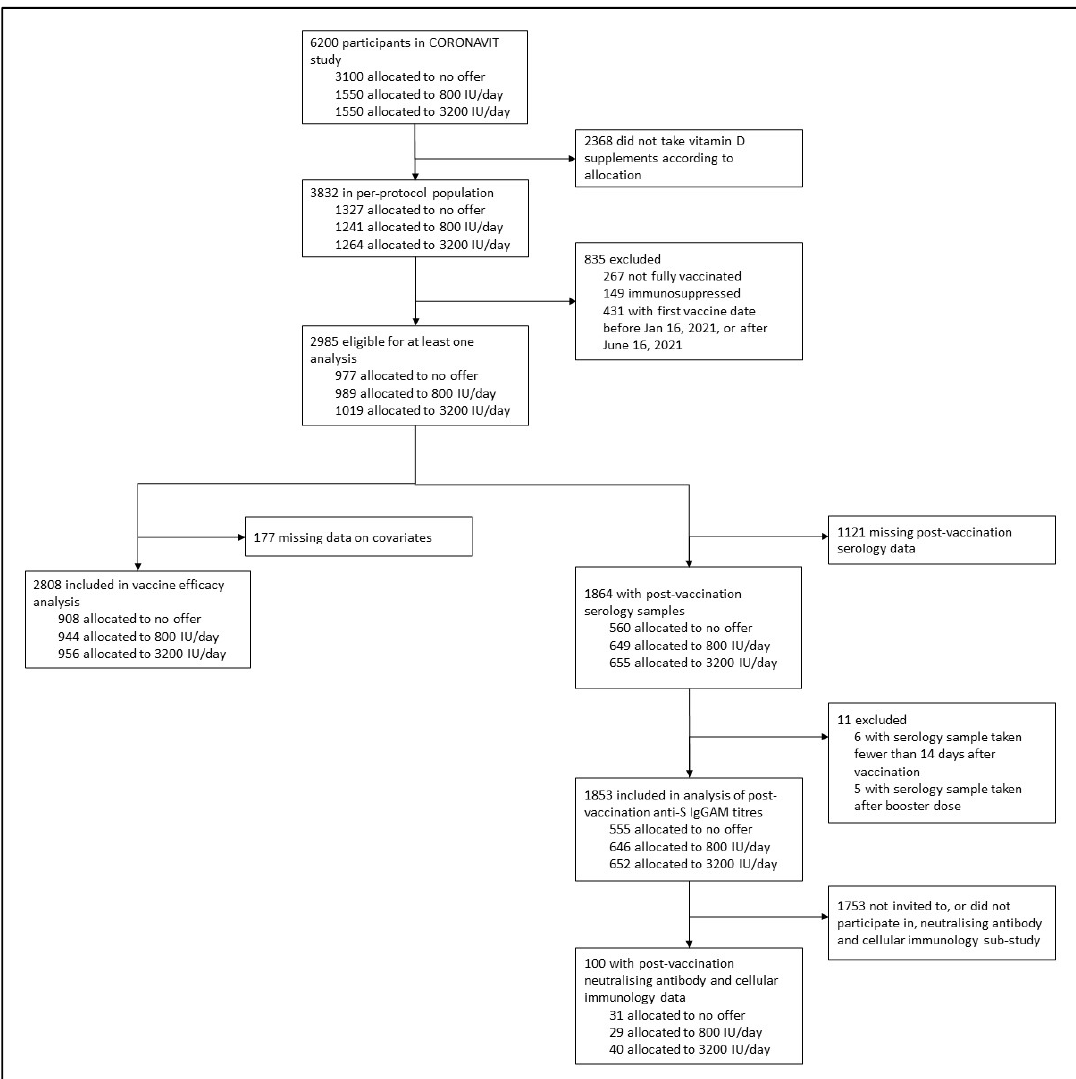
Figure 1. Participant flow.